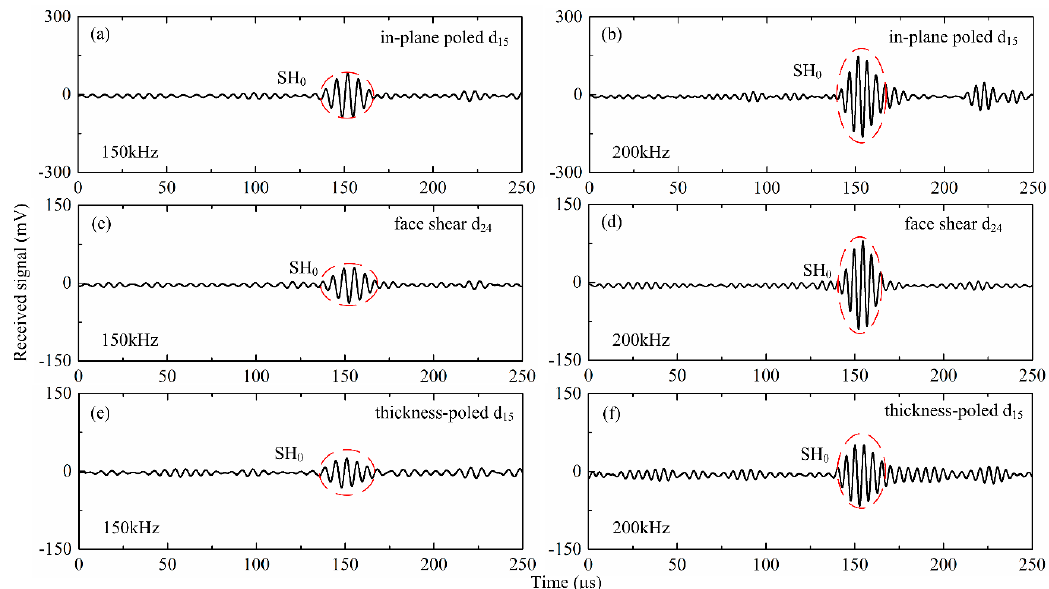
Figure 7. Wave signals generated by different shear mode piezoelectric wafers and received by the d 36 type PMN-PT wafer with drive voltage of 20 V at 150 kHz (left) and 200kHz (right). ( a , b ): in-plane poled d 15 mode; ( c , d ): face shear d 24 mode; ( e , f ): thickness-poled d 15 mode.